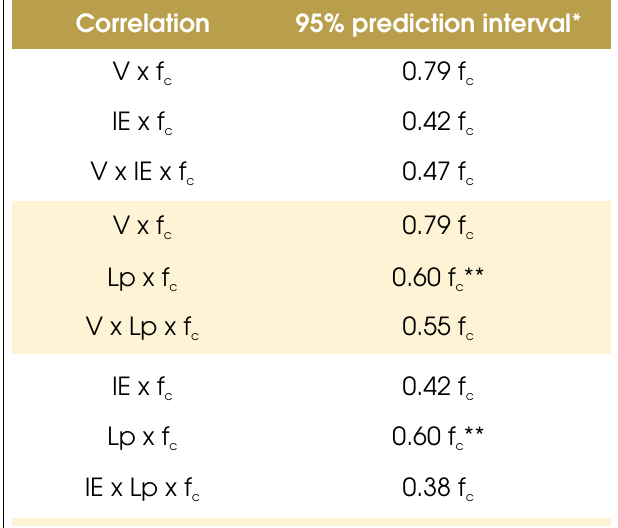
Table 9 – Comparison between the 95% prediction intervals of the studied relationships